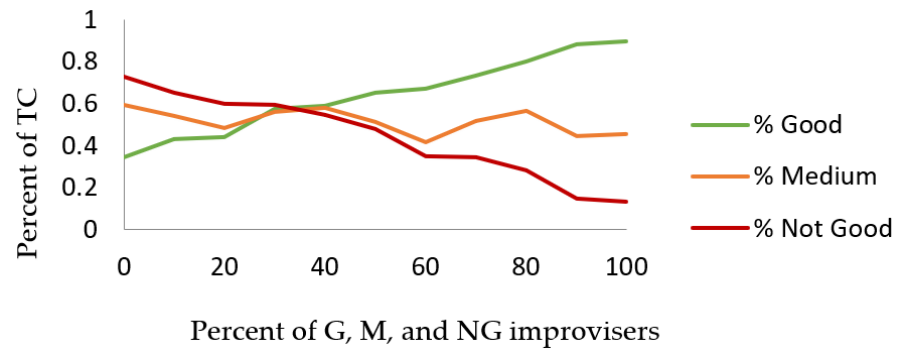
Figure 5. Percent of TC versus percent of Good (G), Medium (M), and Not Good (NG) improvisers.